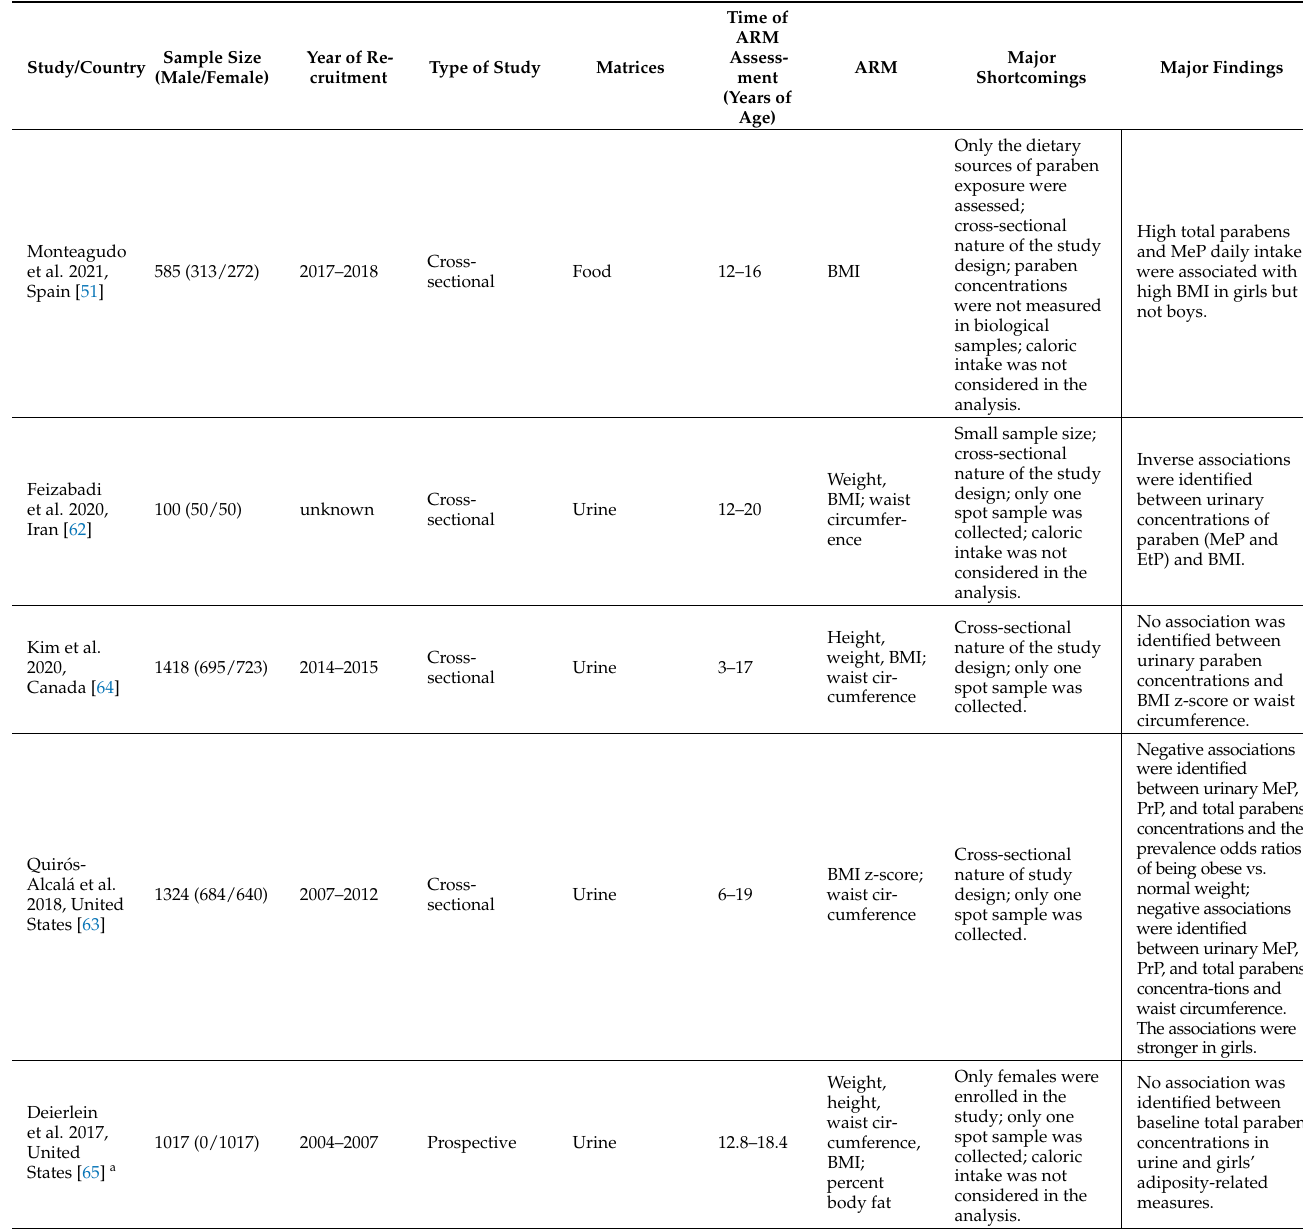
Table 2. Association of paraben exposure during adolescence and adiposity-related measures